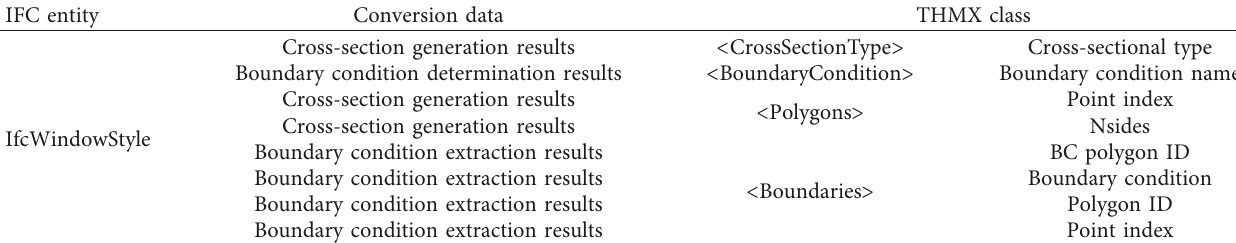
Table 2: Mapping from IFC to